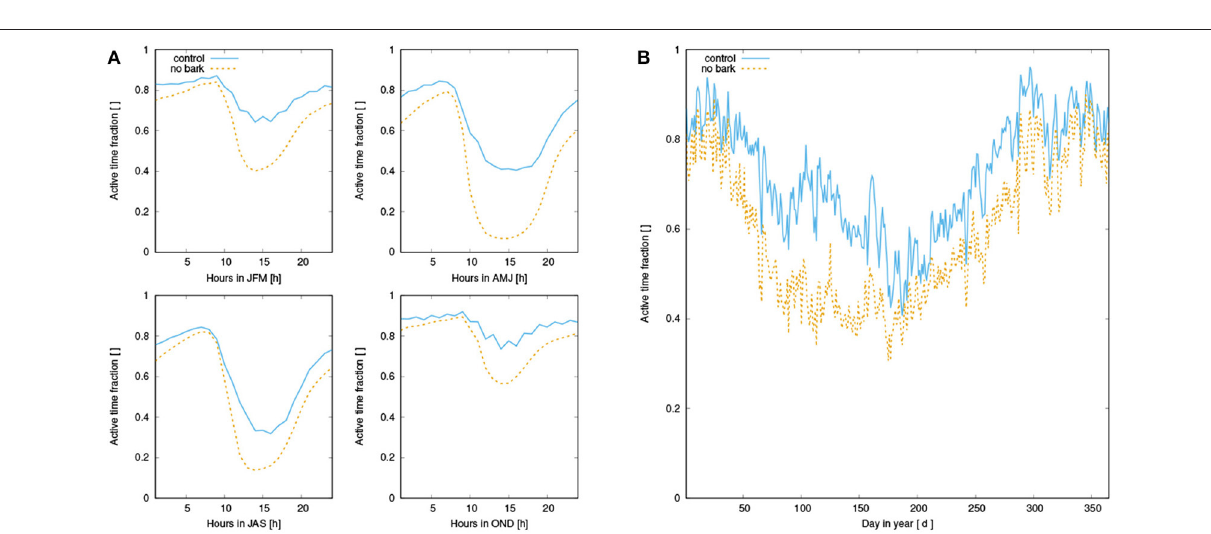
Frontiers in Forests and Global Change |